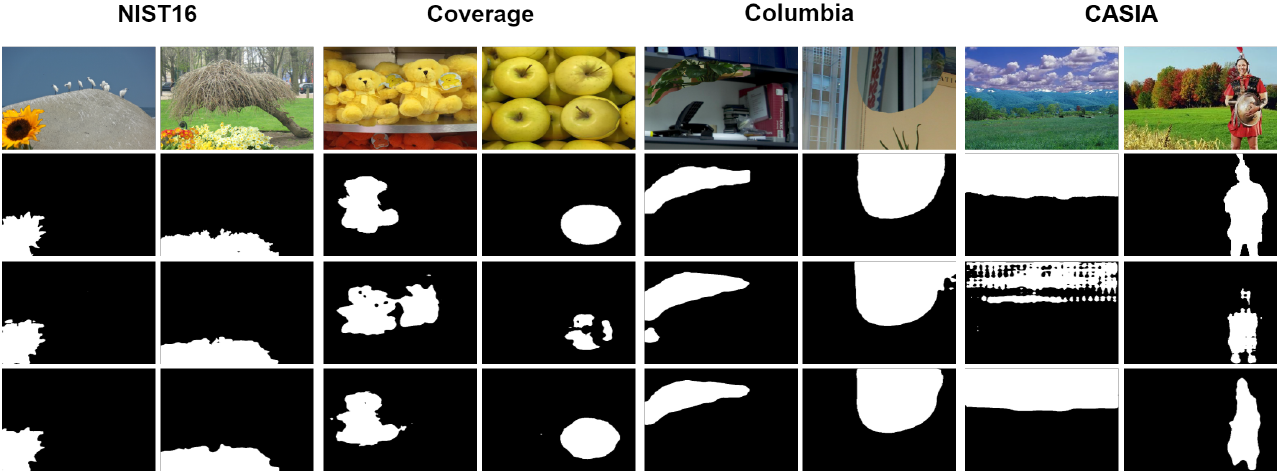
Figure 6. Qualitative visualization of prediction results on NIST16, Coverage, Columbia, and CASIA. From top to bottom are the manipulated image, corresponding ground-truth, the prediction results of basic encoder–decoder, and our proposed Multi-Supervised Encoder–Decoder